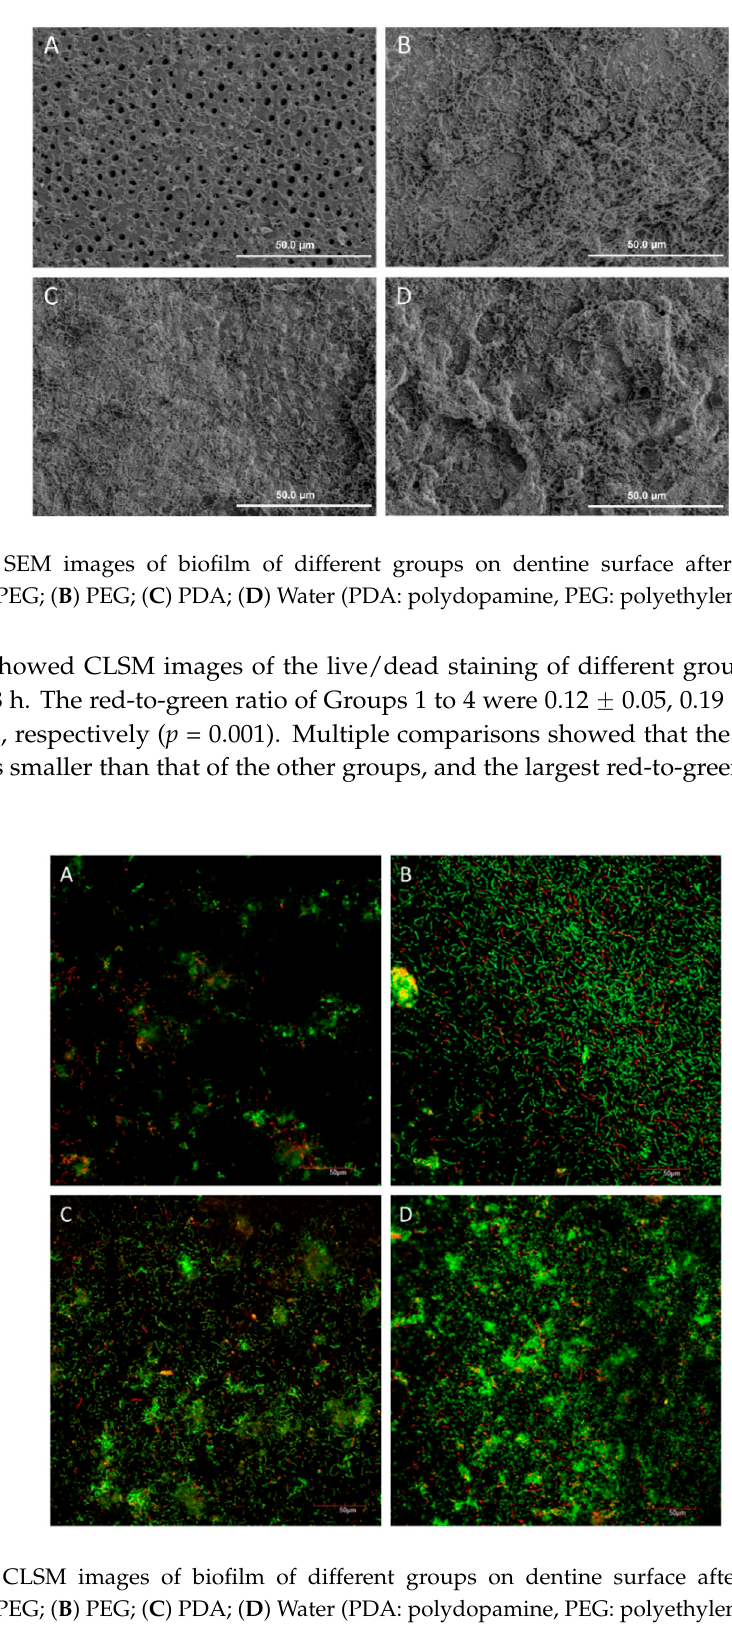
Figure 5. CLSM images of biofilm of different groups on dentine surface after 48 h (×400). ( A ) PDA + PEG; ( B ) PEG; ( C ) PDA; ( D ) Water (PDA: polydopamine, PEG: polyethylene glycol).